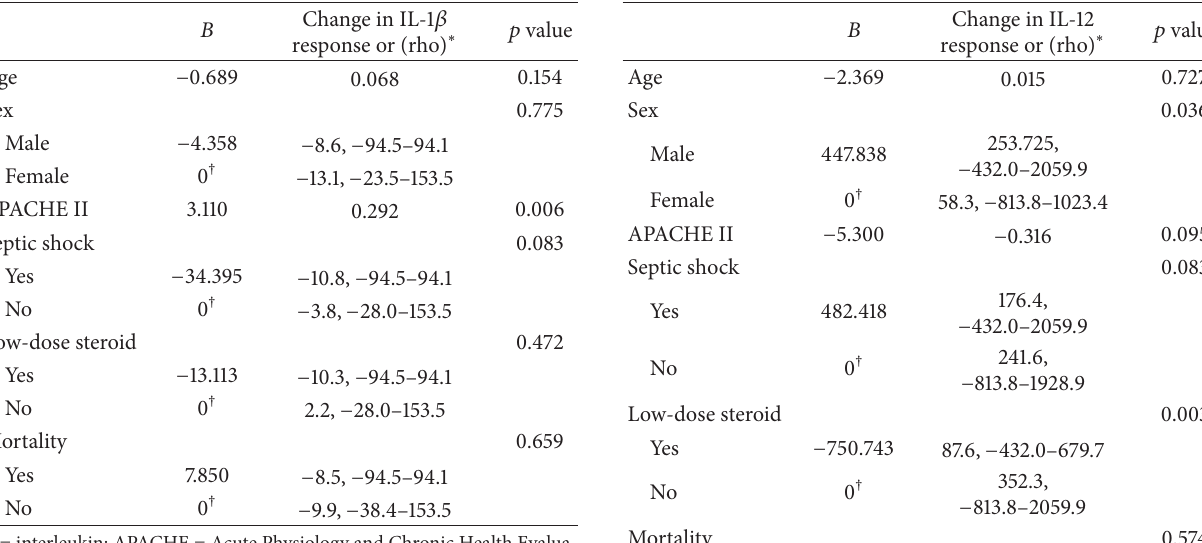
Table 5: Generalized linear model analysis for the change in IL-1 𝛽 response to identify independent factors among clinical characteristics and steroid use.